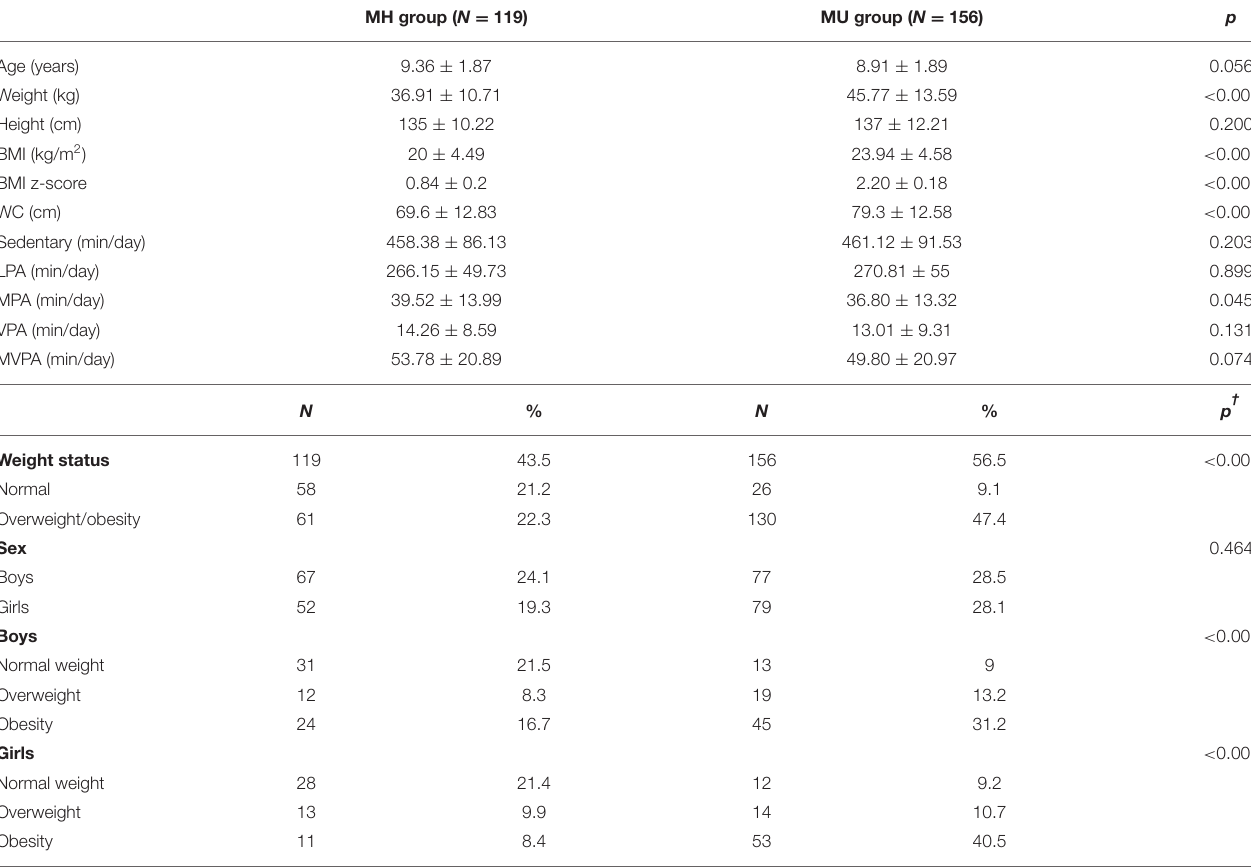
TABLE 1 | Demographic, anthropometric, and physical activity intensities compared between prepubertal children of metabolically healthy or unhealthy